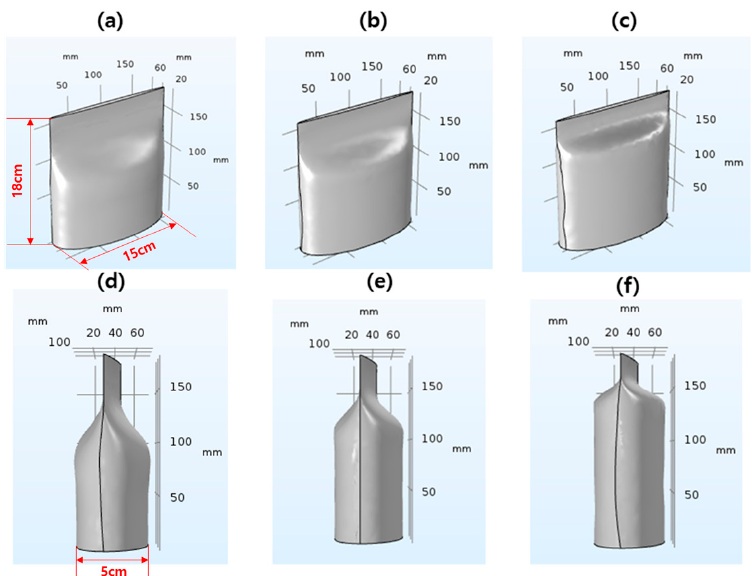
Figure 1. Geometric designs of vacuum-packed BF for simulation. Diagonal view of ( a ) 100 g, ( b ) 150 g, and ( c ) 200 g, and side view of ( d ) 100 g, ( e ) 150 g, and ( f ) 200 g pouches.